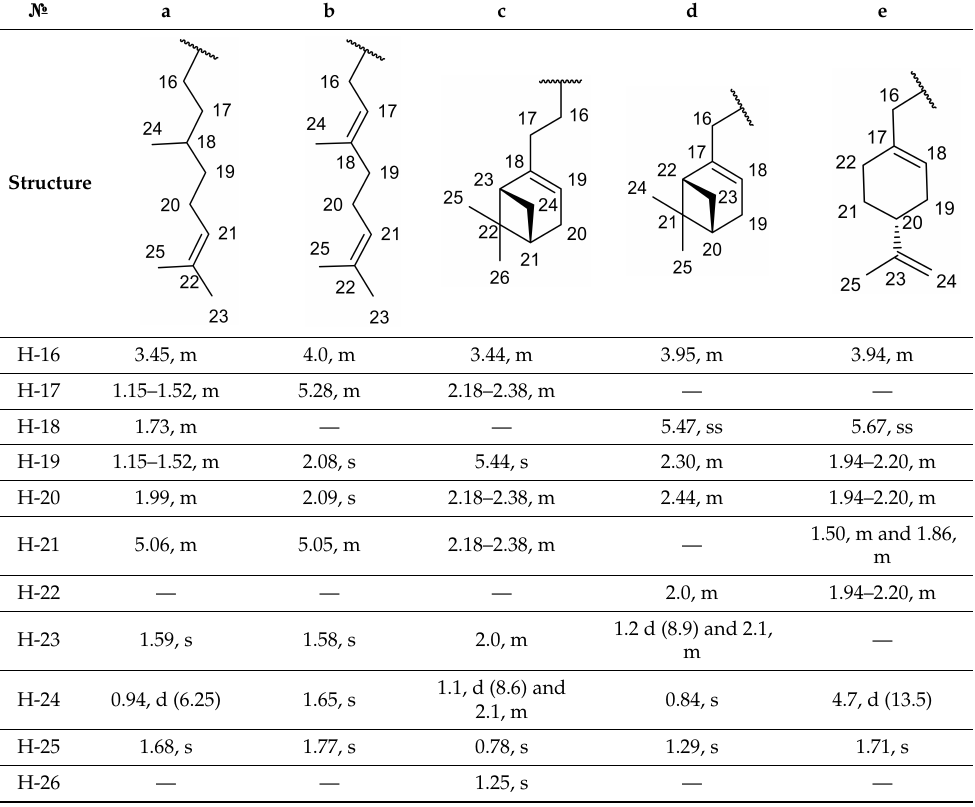
powder with a 75% yield. NMR 1 H: see Table 1. NMR 13 C: see Table 2. HRMS: m / z 481.2457